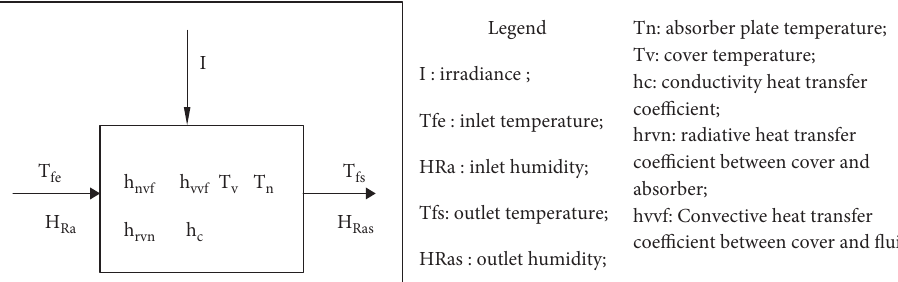
Figure 6: Phenomenon of solar energy transformation in the thermal